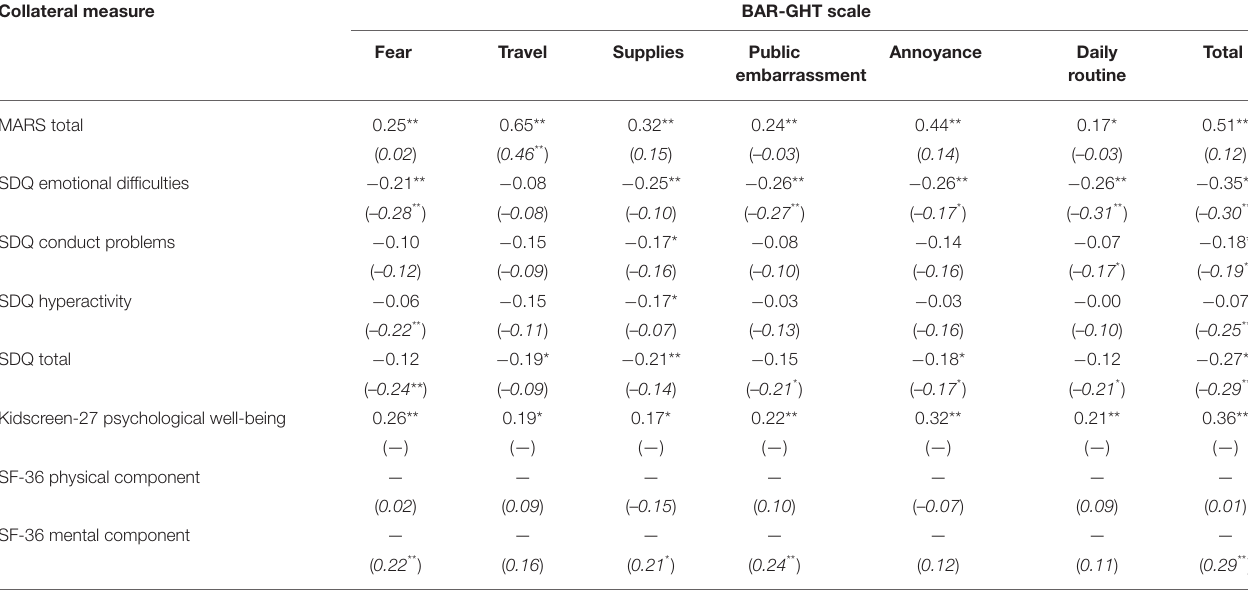
TABLE 5 | Spearman correlations between BAR-GHT scales and collateral measures. Collateral measure BAR-GHT scale Fear Travel Supplies